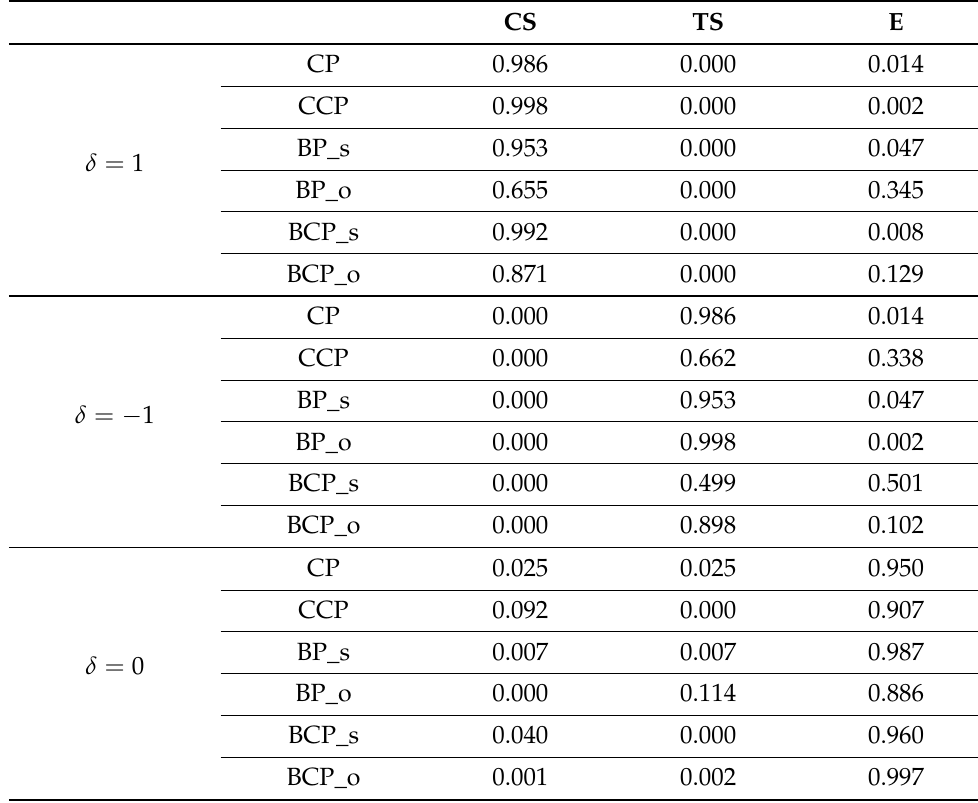
Table 2. The probabilities of CS, TS, and E for CP, CCP, BP_s, BP_o, BCP_s, and BCP_o when δ = 1 (favors control), − 1 (favors treatment), and 0 (favors equivocal).